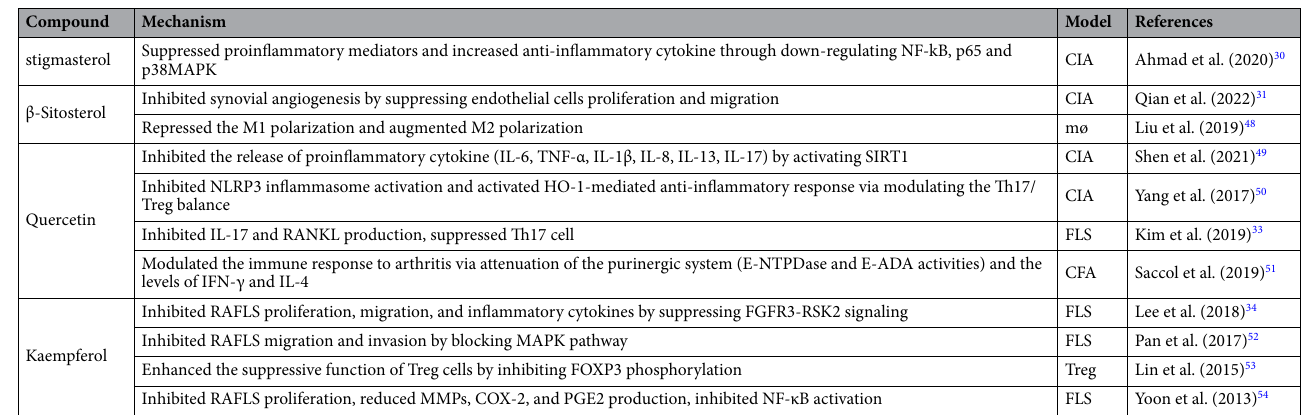
Table 2. Potential anti-RA mechanisms of some